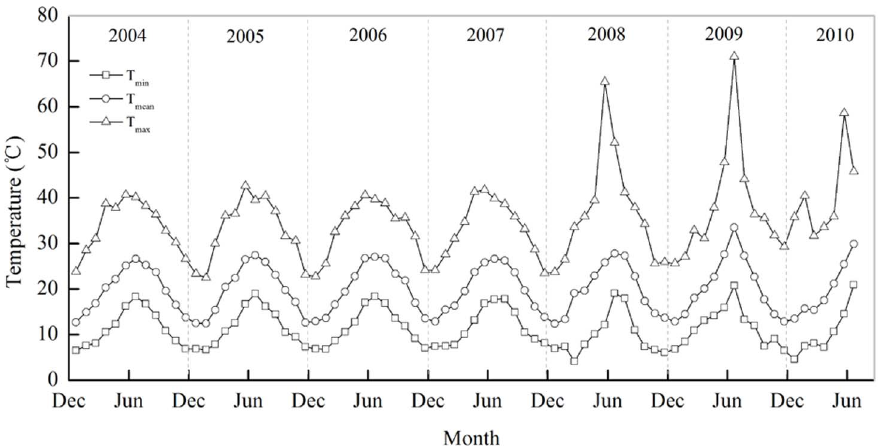
Figure 1. The monthly mean temperature, minimum and maximum temperature inside greenhouse from 2004WS to 2009AW in the year-round greenhouse tomato planting system in Shouguang, northern China.